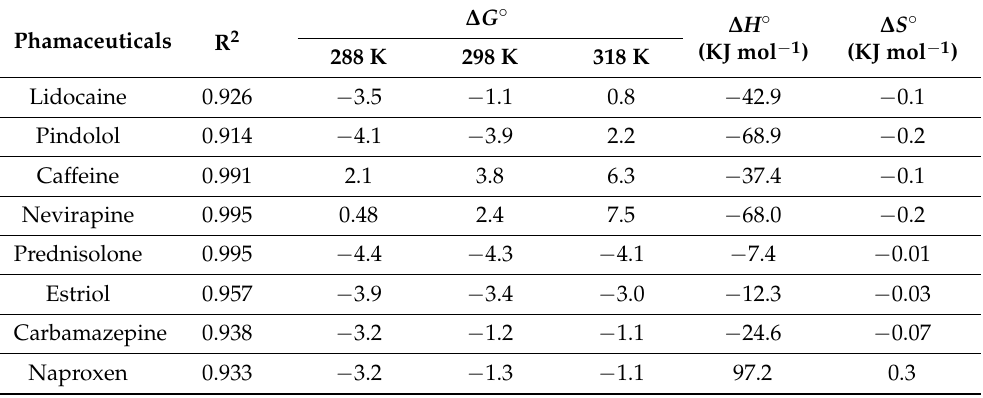
Table 4. Thermodynamic